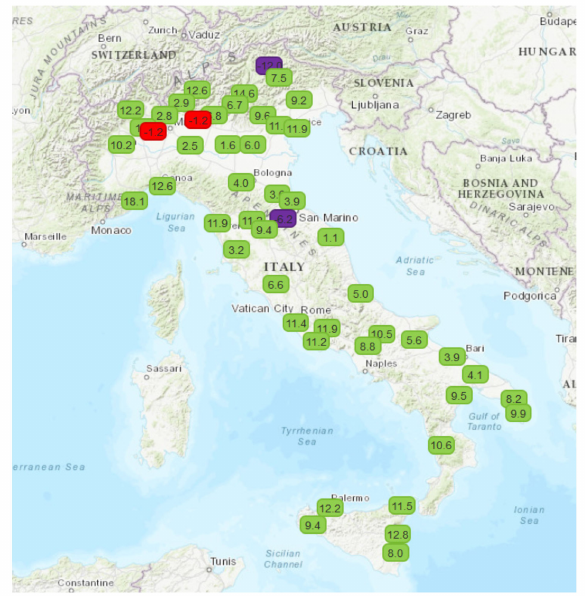
Figure 6. An example of a real-time map for the Scharlau